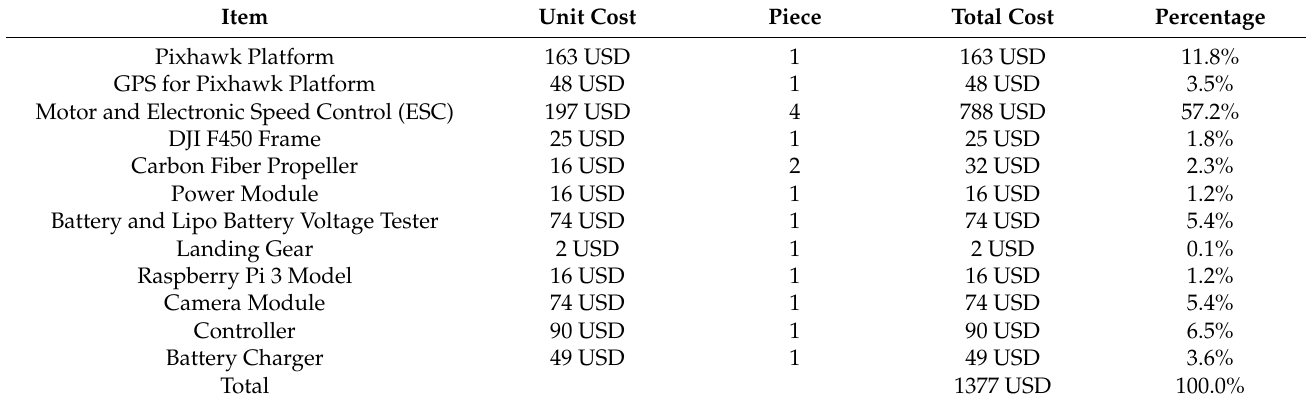
Table 1. Specifications and cost for the drone and attached equipment.